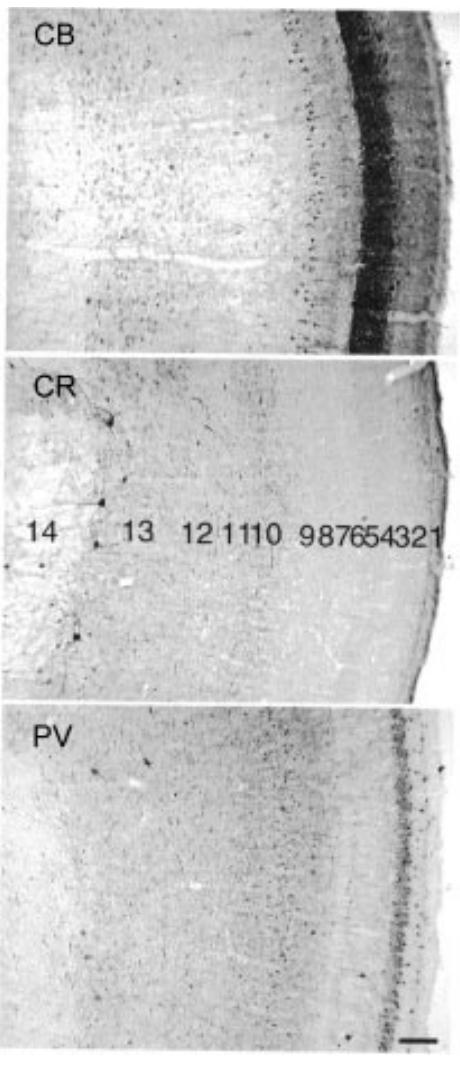
Figure 1 - Digital images of coro- nal sections of the chick brain illustrating the pattern of immu- noreactivity for calbindin (CB), calretinin (CR), and parvalbumin (PV) in the optic tectum. The numbers in the middle image in- dicate the approximate localiza- tion of the different tectal lay- ers. Scale bar: 100